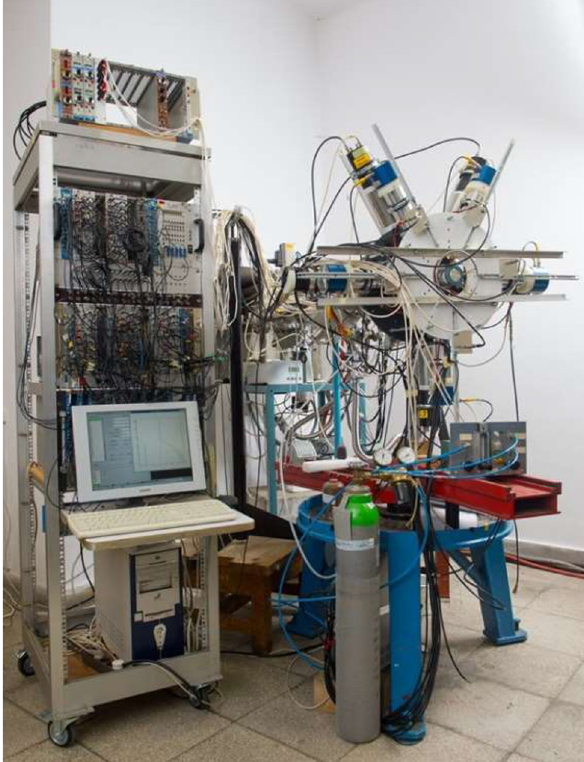
Fig. 2 The Atomki 5 arms spectrometer used in the first 8 Be measure- ment in